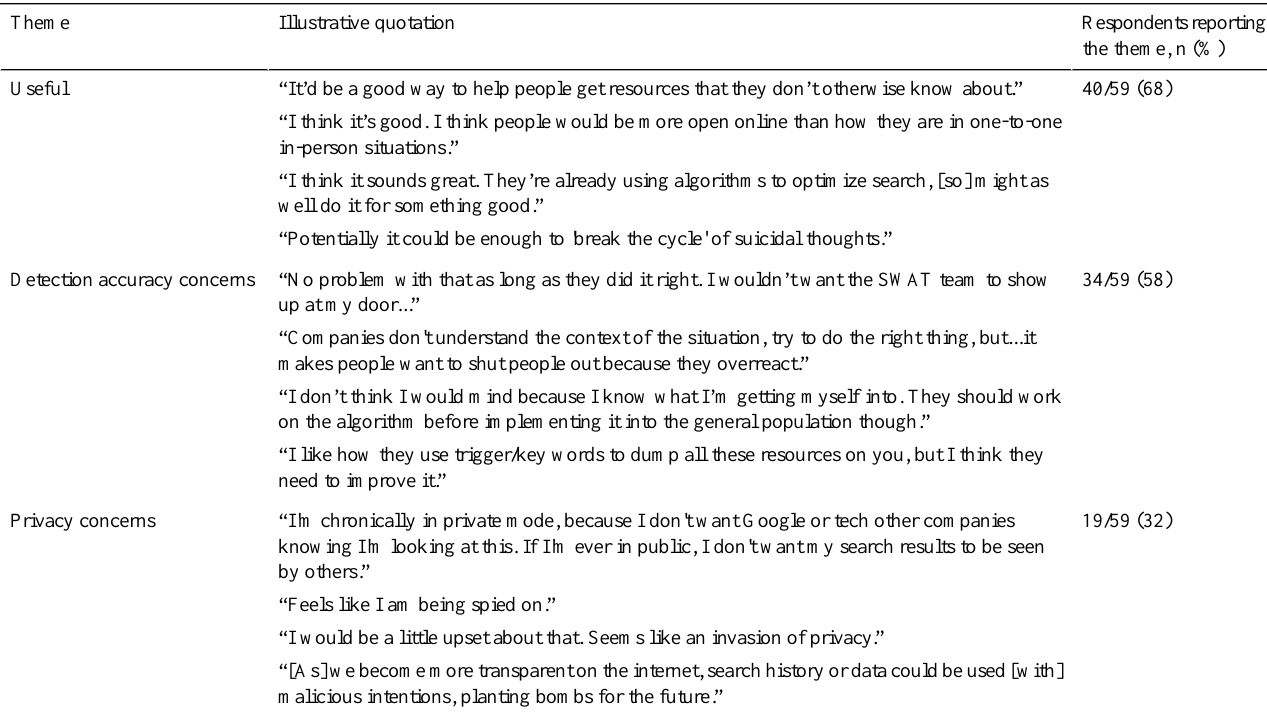
Table 3. Illustrative quotes of participant responses to use of internet history in suicide prevention.